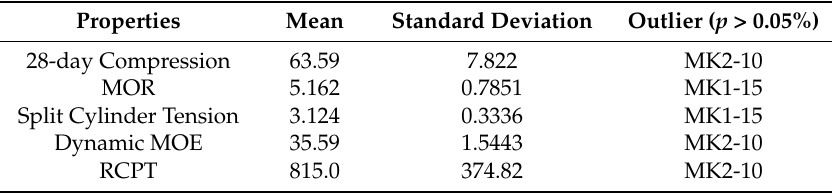
Table 5. Mean, standard deviation, and an outlier of the binary mixture results.